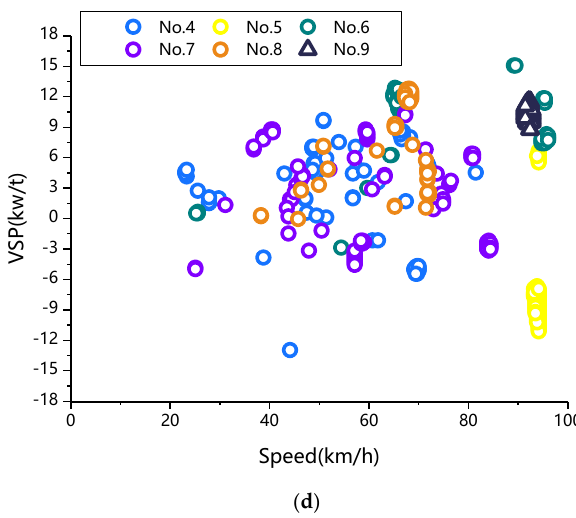
Figure 6. The distribution of these 100 high-emission points in the speed-VSP interval of each pollutant for each test vehicle. ( a ) The high-emission points of CO; ( b ) The high-emission points of HC; ( c ) The high-emission points of NOx; ( d ) The high-emission points of PN.